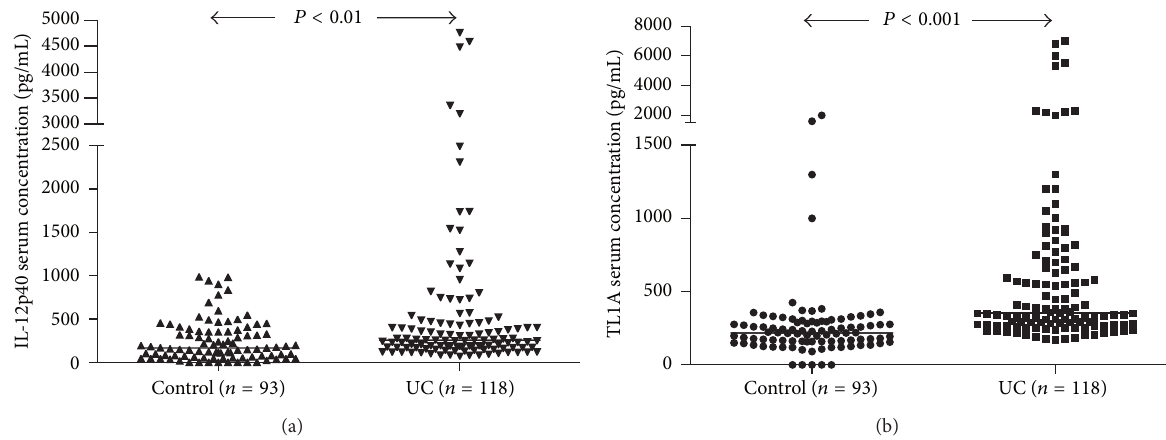
Figure 2: Serum IL-12p40 and TL1A levels were elevated in patients with UC. (a) Levels of IL-12p40 were higher in patients with UC (median, 95% CI: 255.59, 68.16–4756.60 pg/mL) than healthy controls (164.43, 0.1–986.43 pg/mL, 𝑃 < 0.01 ). (b) Serum TL1A concentrations were significantly increased in UC (354.24, 172.78–7113.24 pg/mL) as compared with healthy controls (218.95, 0–2032.06 pg/mL, 𝑃 < 0.001 ). P values refer to Mann-Whitney U test (for 2-group comparison). Horizontal lines represent median values for each group.